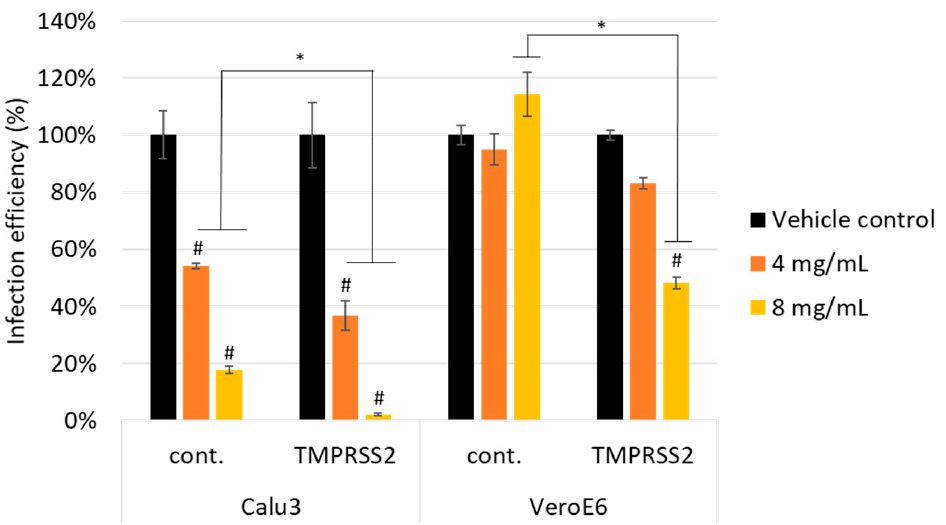
Figure 4. Scutellaria barbata inhibited pseudovirus infection through TMPRSS2. Calu3 and VeroE6 cells with and without TMPRSS2 over-expression were pre-treated with Scutellaria barbata and then infected with SARS-CoV-2 spike pseudovirus. After 24 h infection, infection efficiency rate was measured according to luciferase activities. All data were represented as mean ± SD. Statistical significance was calculated using student t -test. ANOVA was performed when multiple comparisons were evaluated. #, p value < 0.05 compared with vehicle control. *, p value < 0.05 indicates between control cells and TMPRSS2 over-expressing cells.